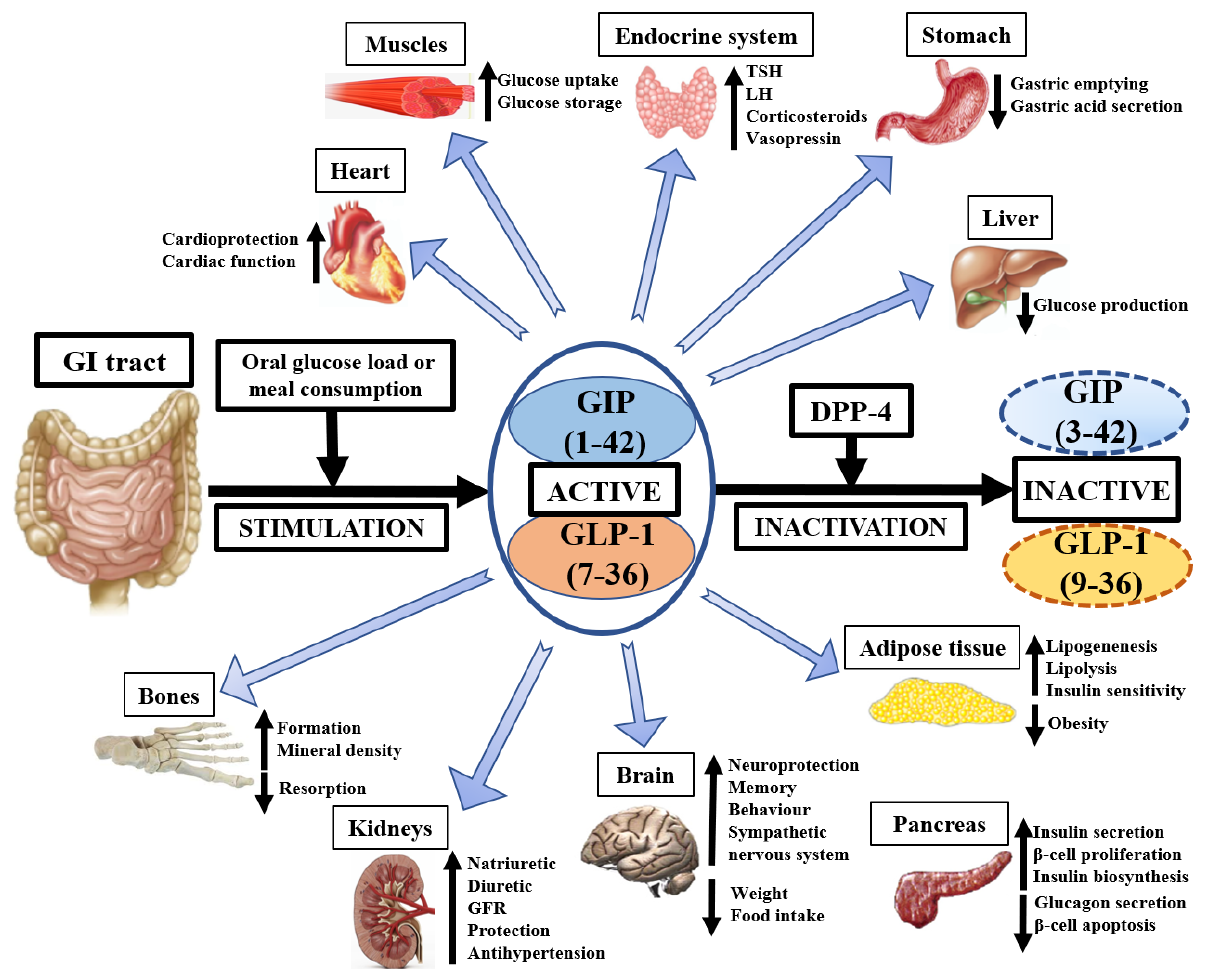
Figure 1. The pleiotropic physiological importance of GIP, GLP-1, and DPP-4 in medicine . GI—gastrointestinal, GIP— glucose-dependent insulinotropic polypeptide, GLP-1—glucagon-like peptide-1, DPP-4—dipeptidyl peptidase-4, GFR— glomerular filtration rate, TSH—thyroid-stimulating hormone, LH—luteinizing